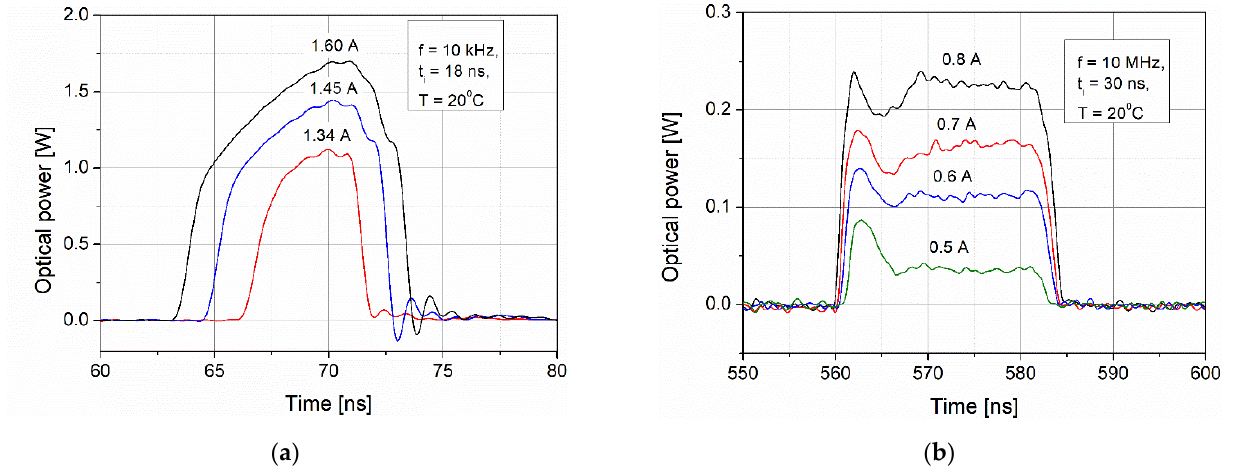
Figure 10. Light pulses for different driving currents for ( a ) pulsed and ( b ) cw lasers.